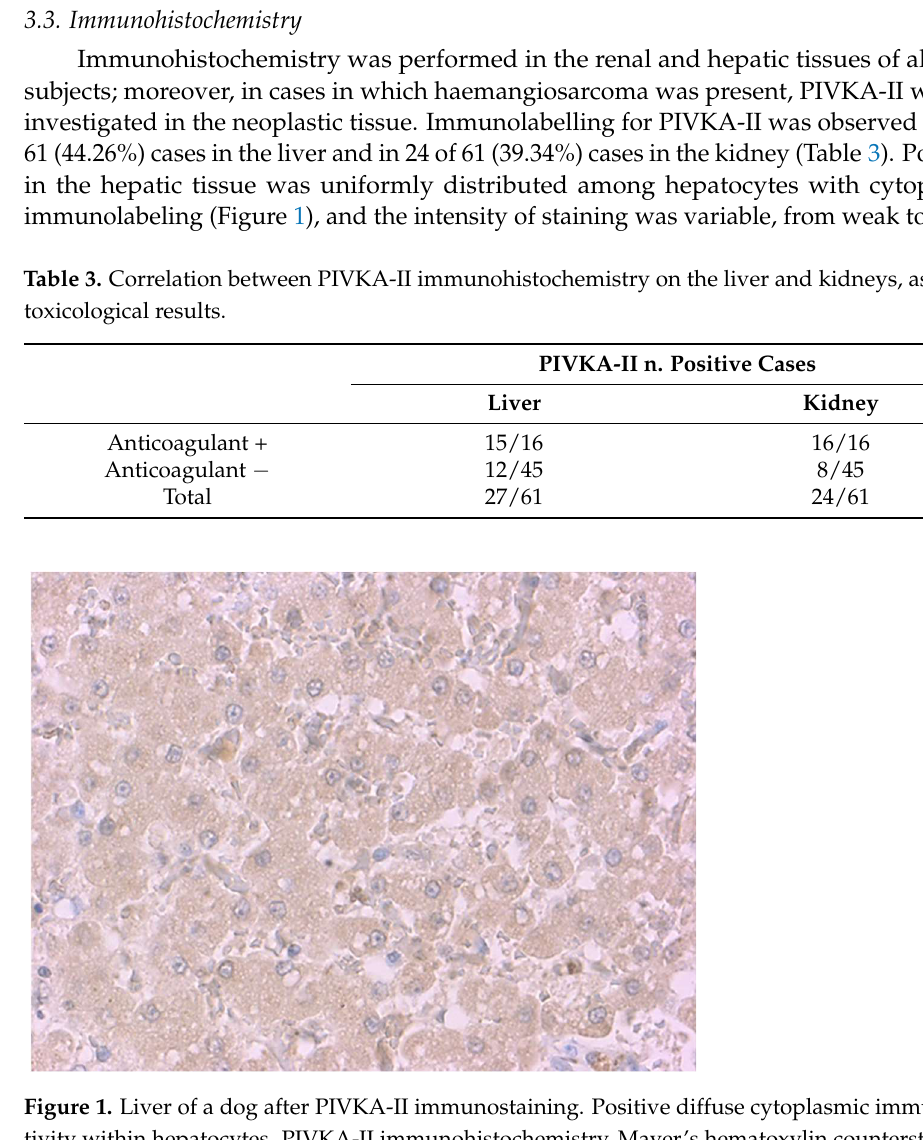
Figure 2. Kidney of a dog after PIVKA-II immunostaining. Positive cytoplasmic immunoreactivity within the renal tubules and Bowman’s capsule. PIVKA-II immunohistochemistry, Mayer’s hematoxylin counterstain, and 20× objectives. When haemangiosarcoma was diagnosed, immunohistochemistry against PIVKA-II was carried out with negative results for all of the cases (Figure 3).